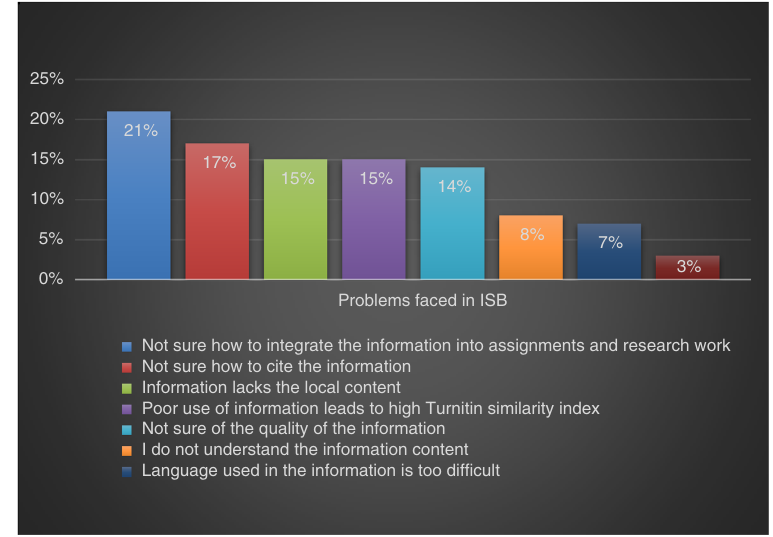
Figure 4. Problems faced in effective utilization of information